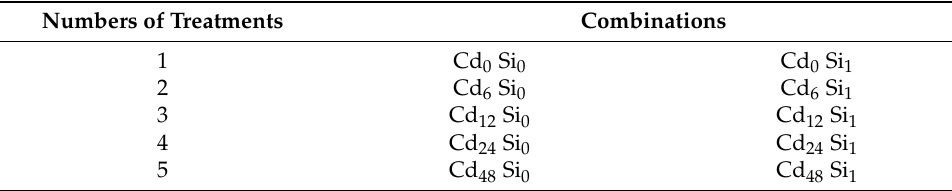
Table 1. Treatments for the